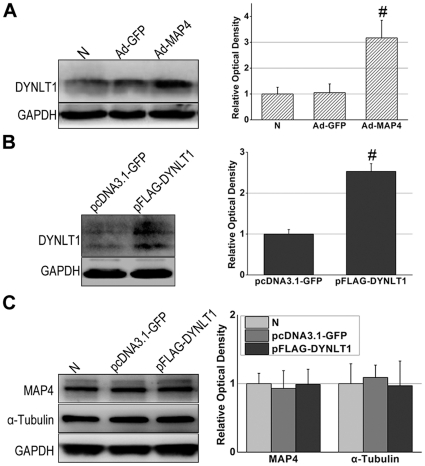
MAP4 overexpression leads to the elevated expression of DYNLT1.
A, Immunoblot of DLNLT1 after MAP4 transfection. HeLa cells with MAP4 overexpression (Ad-MAP4) showed an elevated expression of DYNLT1 compared with non-transfected cells (N) and Ad-GFP transfected cells (Ad-GFP). # P<0.01 vs. N and Ad-GFP. B, Immunoblot of DYNLT1 after transient transfection of the plasmid. DYNLT1 was overexpressed in pFLAG-DYNLT1 cells. * P<0.05 vs. pcDNA3.1-GFP. C, Immunoblot of MAP4 and α-tubulin following up-regulation of DYNLT1 (pFLAG-DYNLT1). There seemed no influence on MAP4 and α-tubulin levels. Graphs represent the mean±SEM (n = 3) of the relative optical density signals.